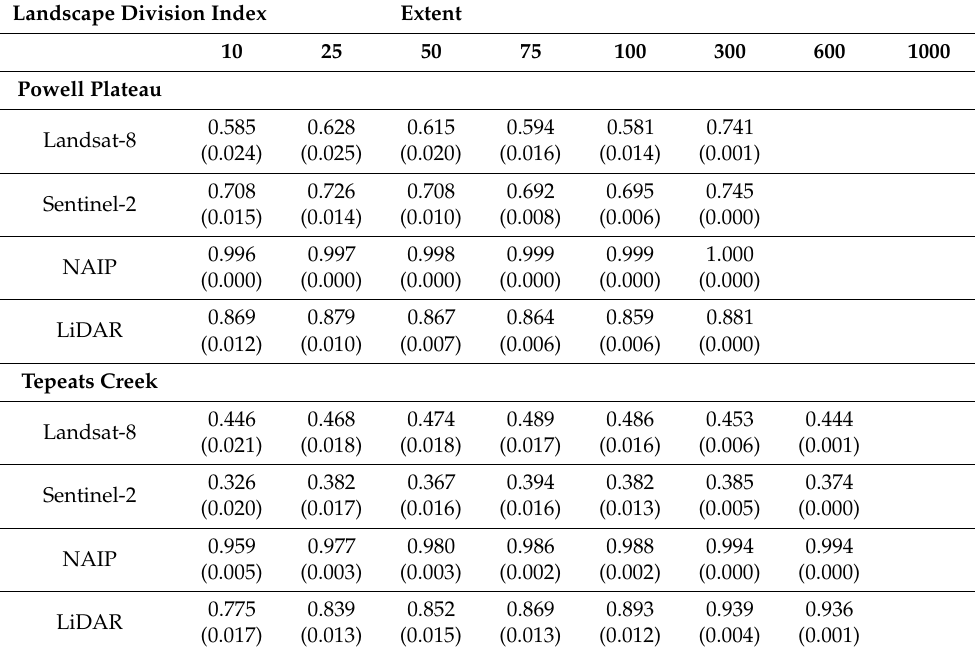
Figure 8. Violin plots (colored by extent and depicting probability density of the data at di ff erent values smoothed by a kernel density estimator), box-and-whisker plots (black and white) and mean (red dot) for landscape division index (%). Landscape division index is presented for each landscape and data product (Landsat-8 30 m, Sentinel-2 10 m, NAIP 1 m, LiDAR 1 m), and across multiple spatial extents and is defined as the probability that two animals placed in di ff erent areas somewhere in the extent might find one another. Insets with rescaled y -axis provided for clarity. Table 7. Landscape division index (LDI) of canopy cover across all three landscapes across for each data product (Landsat-8 30 m, Sentinel-2 10 m, NAIP 1 m, LiDAR 1 m), and across multiple spatial extents. Mean values and standard error (SE) are shown.